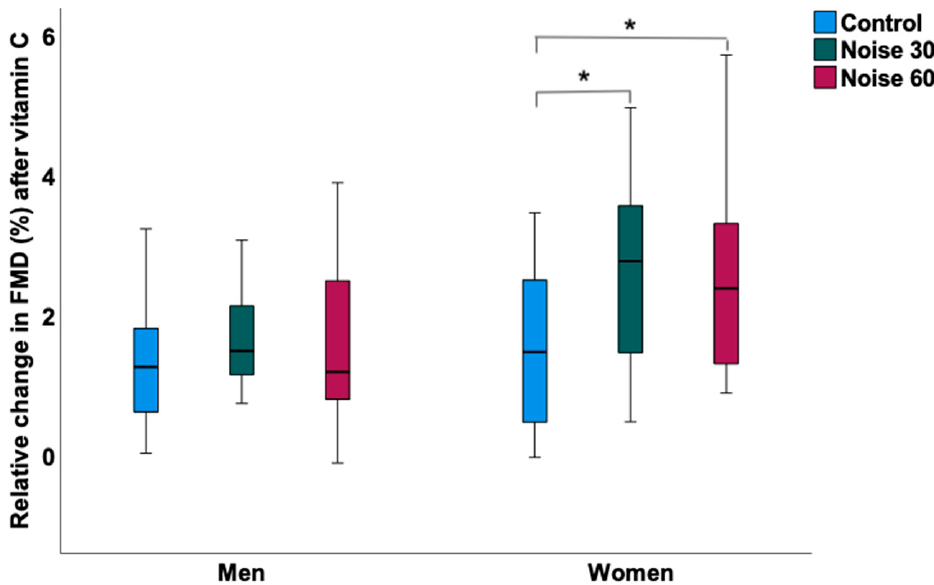
Figure 3. Determination of the effect of vitamin C on relative changes in endothelial function by nocturnal train noise exposure in men ( n = 17) and women ( n = 12). Flow-mediated dilation (FMD) was determined for Control, Noise 30, and Noise 60 study nights prior and post administration of vitamin C, which was used as an antioxidant drug to assess the impact of noise-triggered oxidative stress on endothelial function. Vitamin C significantly improved FMD in noise exposed study nights compared to control nights in women (*), although no difference was observed between Noise 30 and Noise 60 study nights. In men, vitamin C was not significantly associated with improved FMD in noise exposed study nights compared to control nights. Box plots indicate minimum, maximum, 25th percentile, median, and 75th percentile.